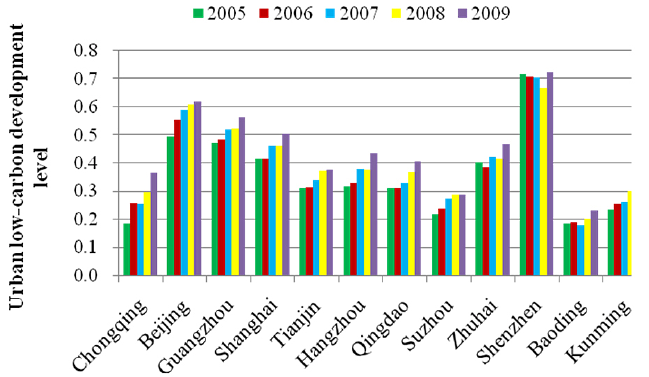
Figure 1. Urban low-carbon development levels of 12 cities from